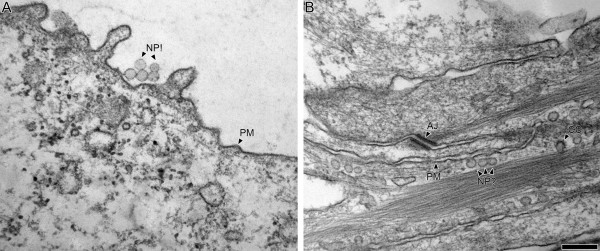
Conventional TEM of polystyrene nanoparticles. This figure demonstrates the impossibility to distinguish between NP and cellular structures by conventional TEM unambiguously. In A, five polystyrene NP (NP!) with a mean diameter of 78 nm are observed next to an A549 cell. Once taken up by the cells, they may have an appearance as shown in B. It is very likely that the spherical structures in B (NP?) are not NP but vesicular structures like caveolae. CC = Clathrin coated vesicle; PM = Plasma membrane; AJ = Adherens junction. Chemical fixation, Epon embedding, 40–70 nm sections. Bar = 1 μm (A and B are at identical magnification).